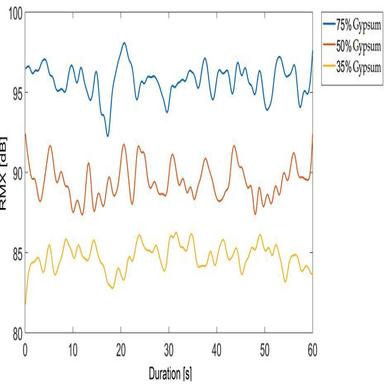
Evaluation of the AE test series of different gypsum and anhydrite proportions.